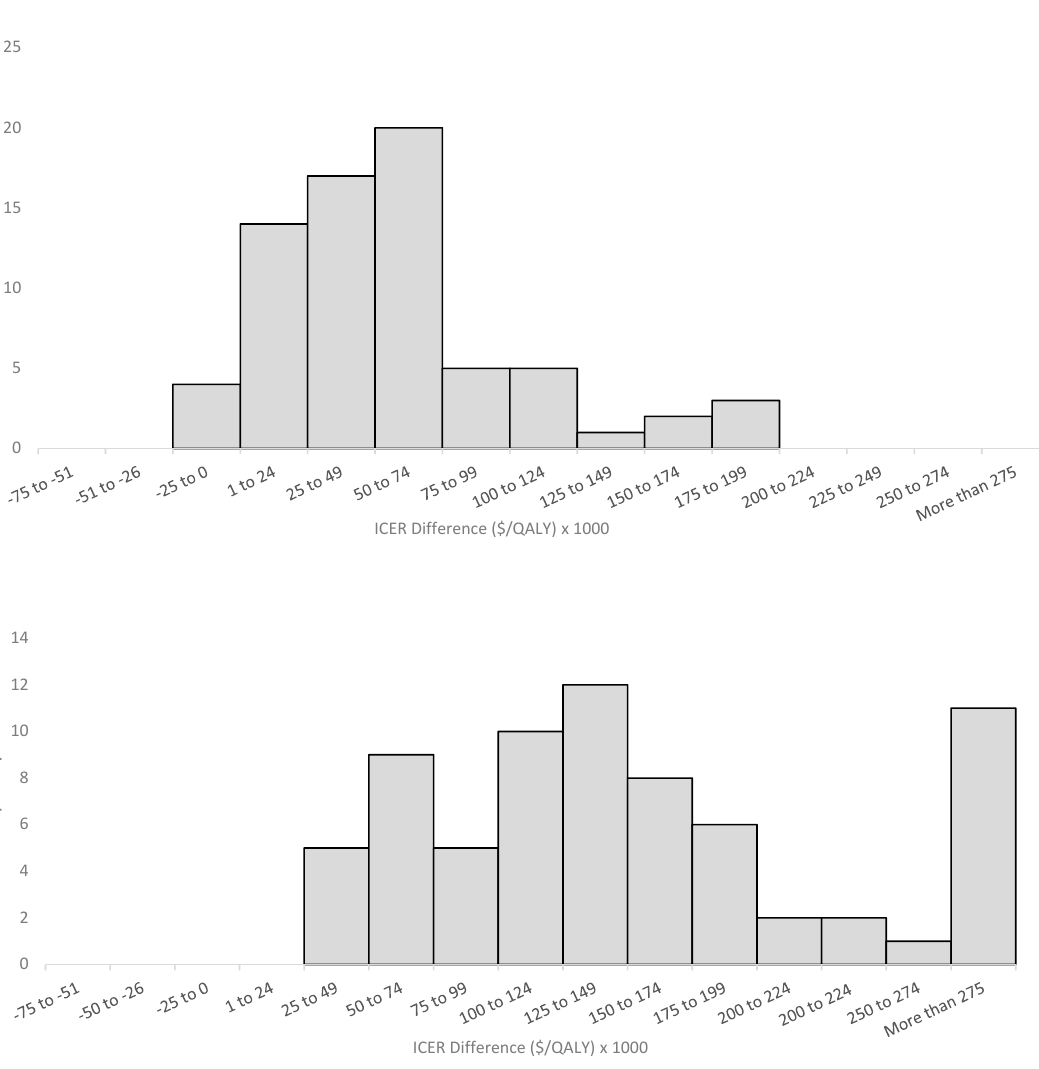
Figure 3. Histogram of di ff erences between EGP-reanalyzed and manufacturer-submitted ICERs.